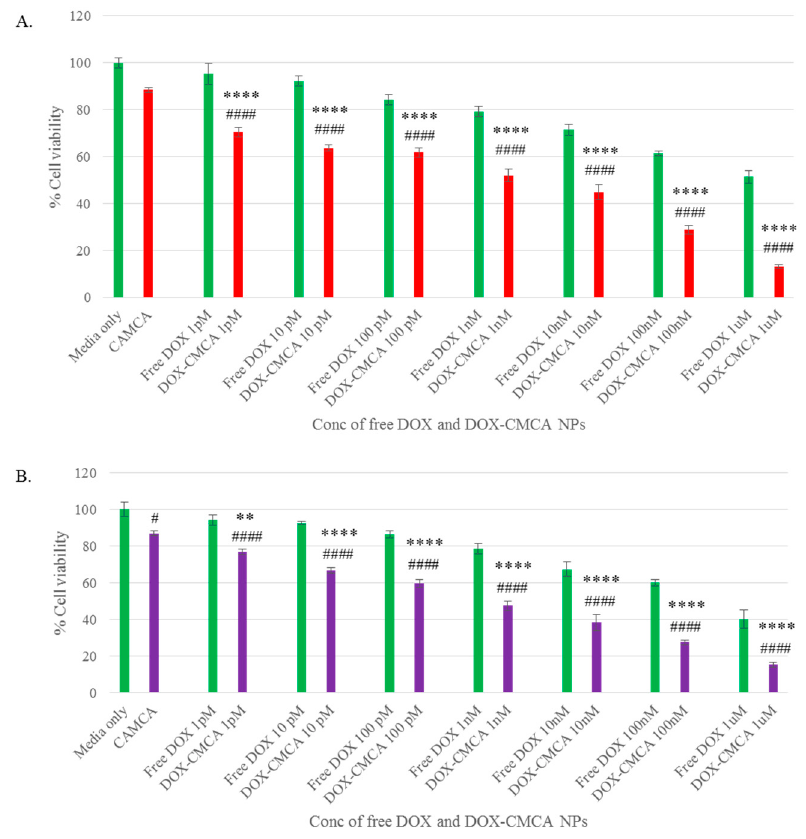
Figure 5. Cytotoxicity assay of DOX-loaded CMCA NPs. ( A ) cell viability assessment by MTT assay after 48 h incubation of the free DOX and DOX-loaded CMCA NPs with MCF-7 cell line; ( B ) cell viability assessment by MTT assay after 48 h incubation of the free DOX and DOX-loaded CMCA NPs with 4T1 cell line. Values were significant (*) at p -value 0.01 to 0.05, very significant (**) at p -value 0.001 to 0.01, highly significant (***) at p -value 0.0001 to 0.001, extremely significant (****) at p -value < 0.0001 vs. same treatment of free DOX. Values were significant (#) at p -value 0.01 to 0.05, very significant (##) at p -value 0.001 to 0.01, highly significant (###) at p -value 0.0001 to 0.001, extremely significant (####) at p -value < 0.0001 vs. untreated cells at CI of 95%.